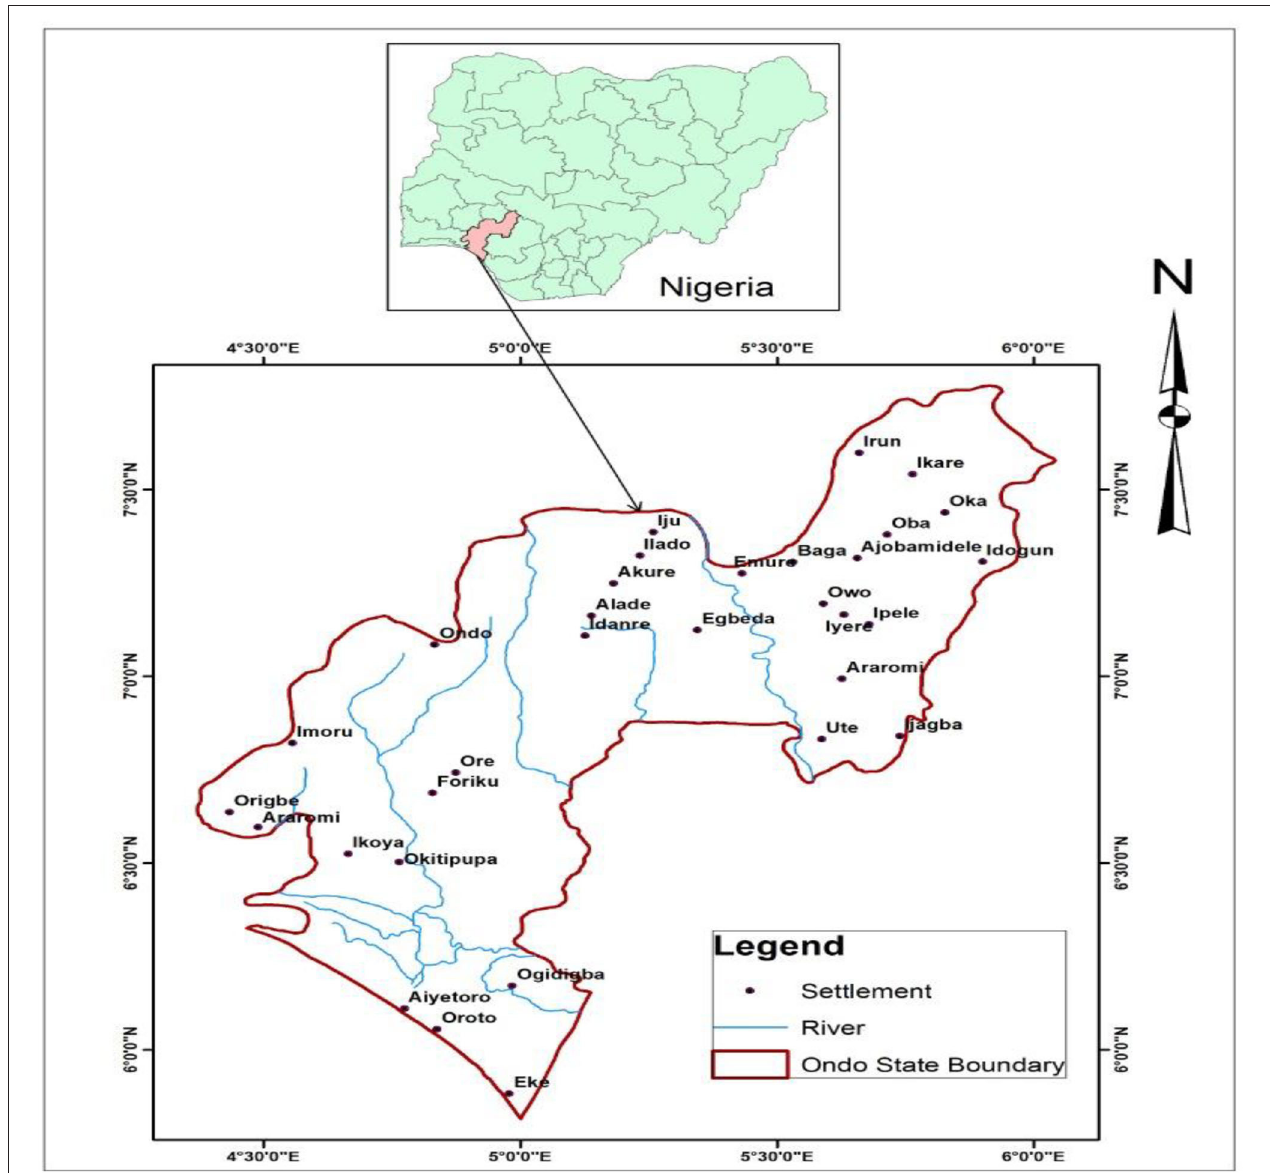
FIGURE 1 | Map of the study